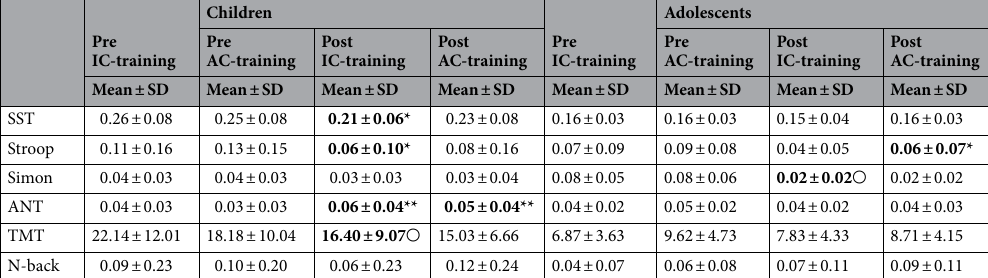
Table 1. Efficiency of EFs in children and adolescents before and after an active control (AC) or an inhibitory control (IC) training. For all tasks, scores were derived from RTs (in s). SST stop signal task, TMT trail making test. Training-related changes in task efficiency were evaluated with repeated measures ANOVAs. Significance levels: ○ < 0.10; *< 0.05; ** < 0.01; *** < 0.001.